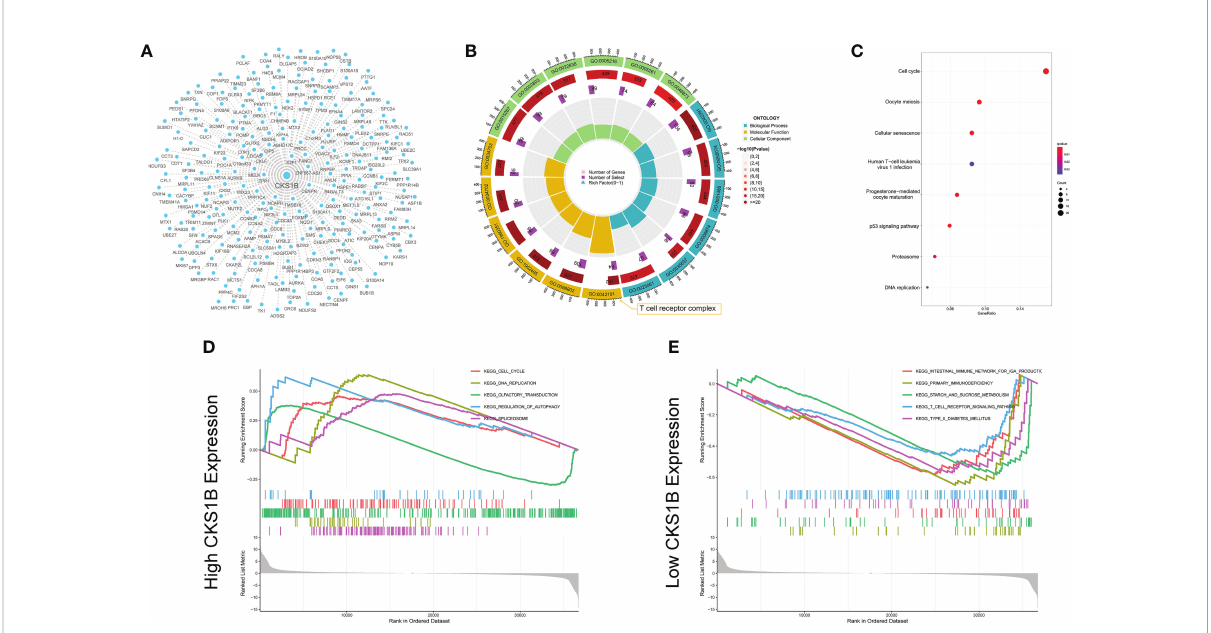
FIGURE 3 Co-expression network construction and enrichment analysis for CKS1B. (A) The co-expression network for 239 CKS1B co-expressed genes. (B) GO enrichment analysis for CKS1B based on CKS1B co-expressed genes. (C) KEGG pathway analysis for CKS1B based on CKS1B co-expressed genes. (D) GSEA enrichment analysis in high CKS1B group. (E) GSEA enrichment analysis in low CKS1B